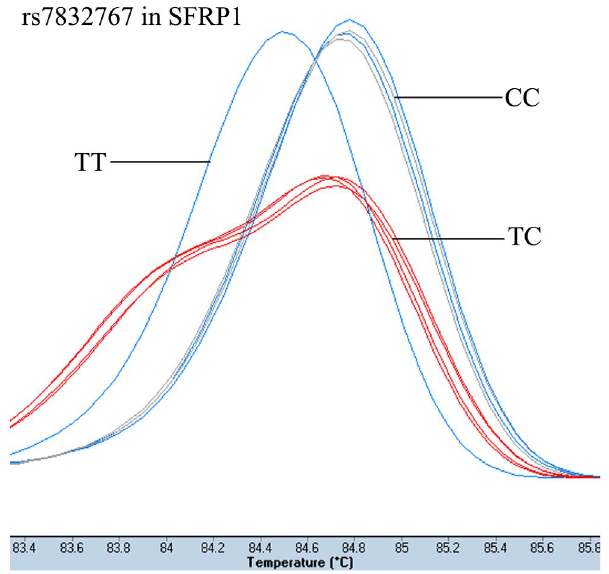
Figure 2. HRM plot of rs7832767.